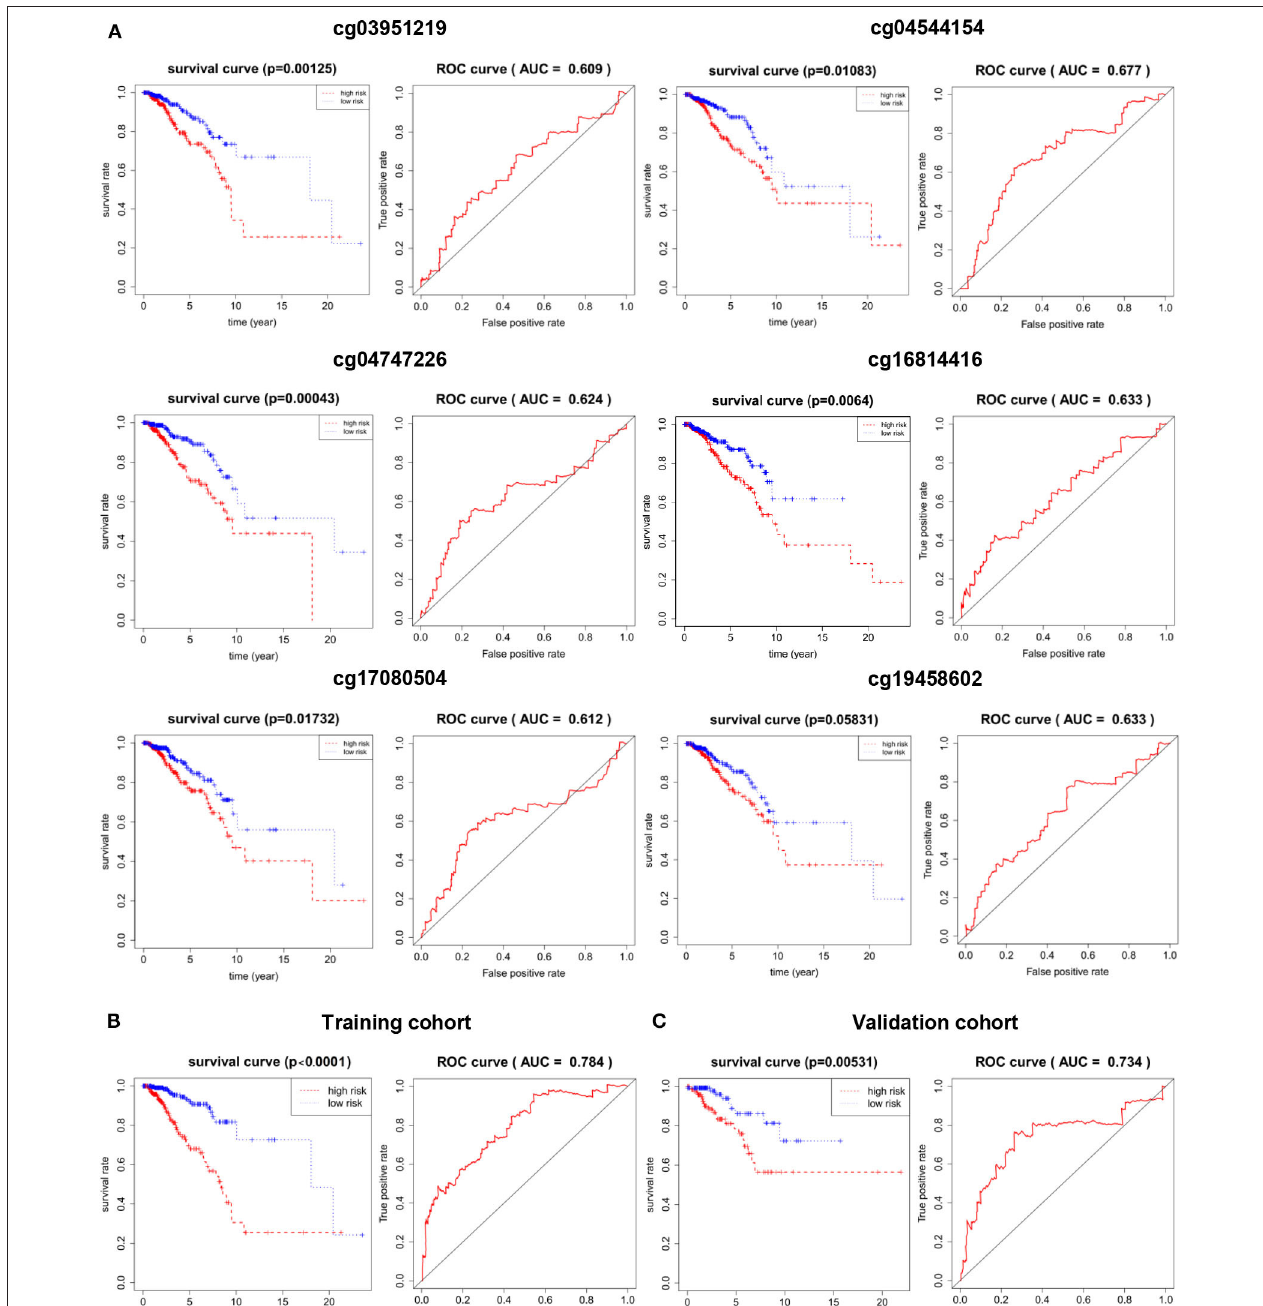
FIGURE 5 | The prognostic potential of the 6 DNA methylation markers. (A) single site of methylation of breast cancer predicted and Kaplan-Meier survival analysis of the AUC of the ROC curve area. (B) Kaplan-Meier survival analysis and sensitivity and specificity for ROC analysis of predictive the power of 6 DNA methylation markers in predicting OS in patients in the training cohort. (C) Kaplan-Meier survival Analysis and ROC analysis in validation